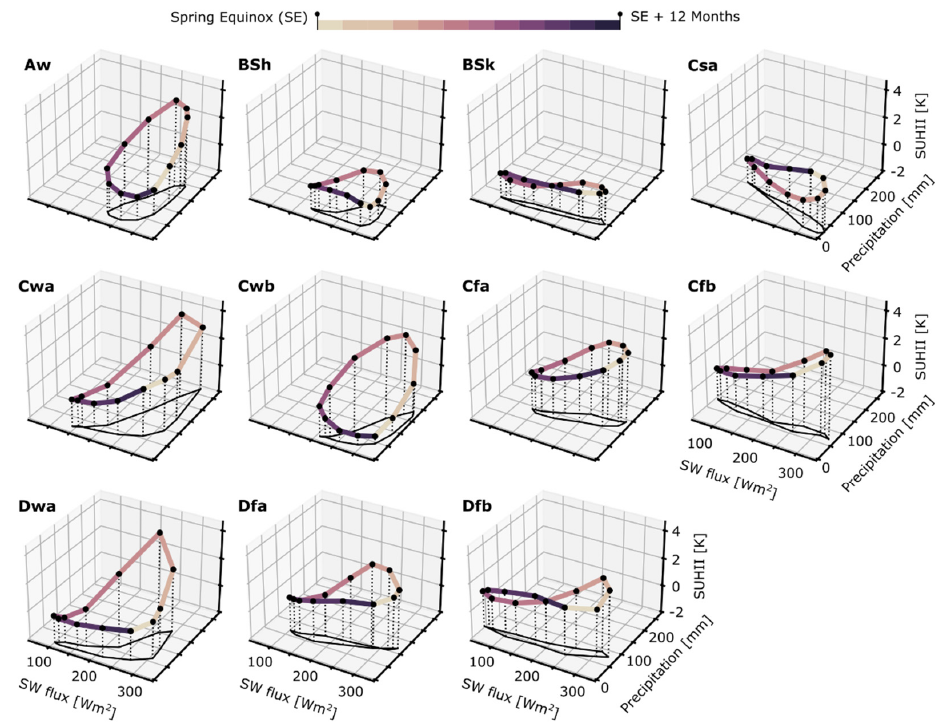
Figure 5. The seasonal variation of precipitation, clear-sky at-surface downwelling shortwave radiation flux (SW), and daytime SUHII for each Köppen–Geiger climate class examined in this work. Each dot represents a month (the start and end points correspond to spring equinox). The monthly means refer to the years 2000–2018 and the color of the line indicates the direction of each